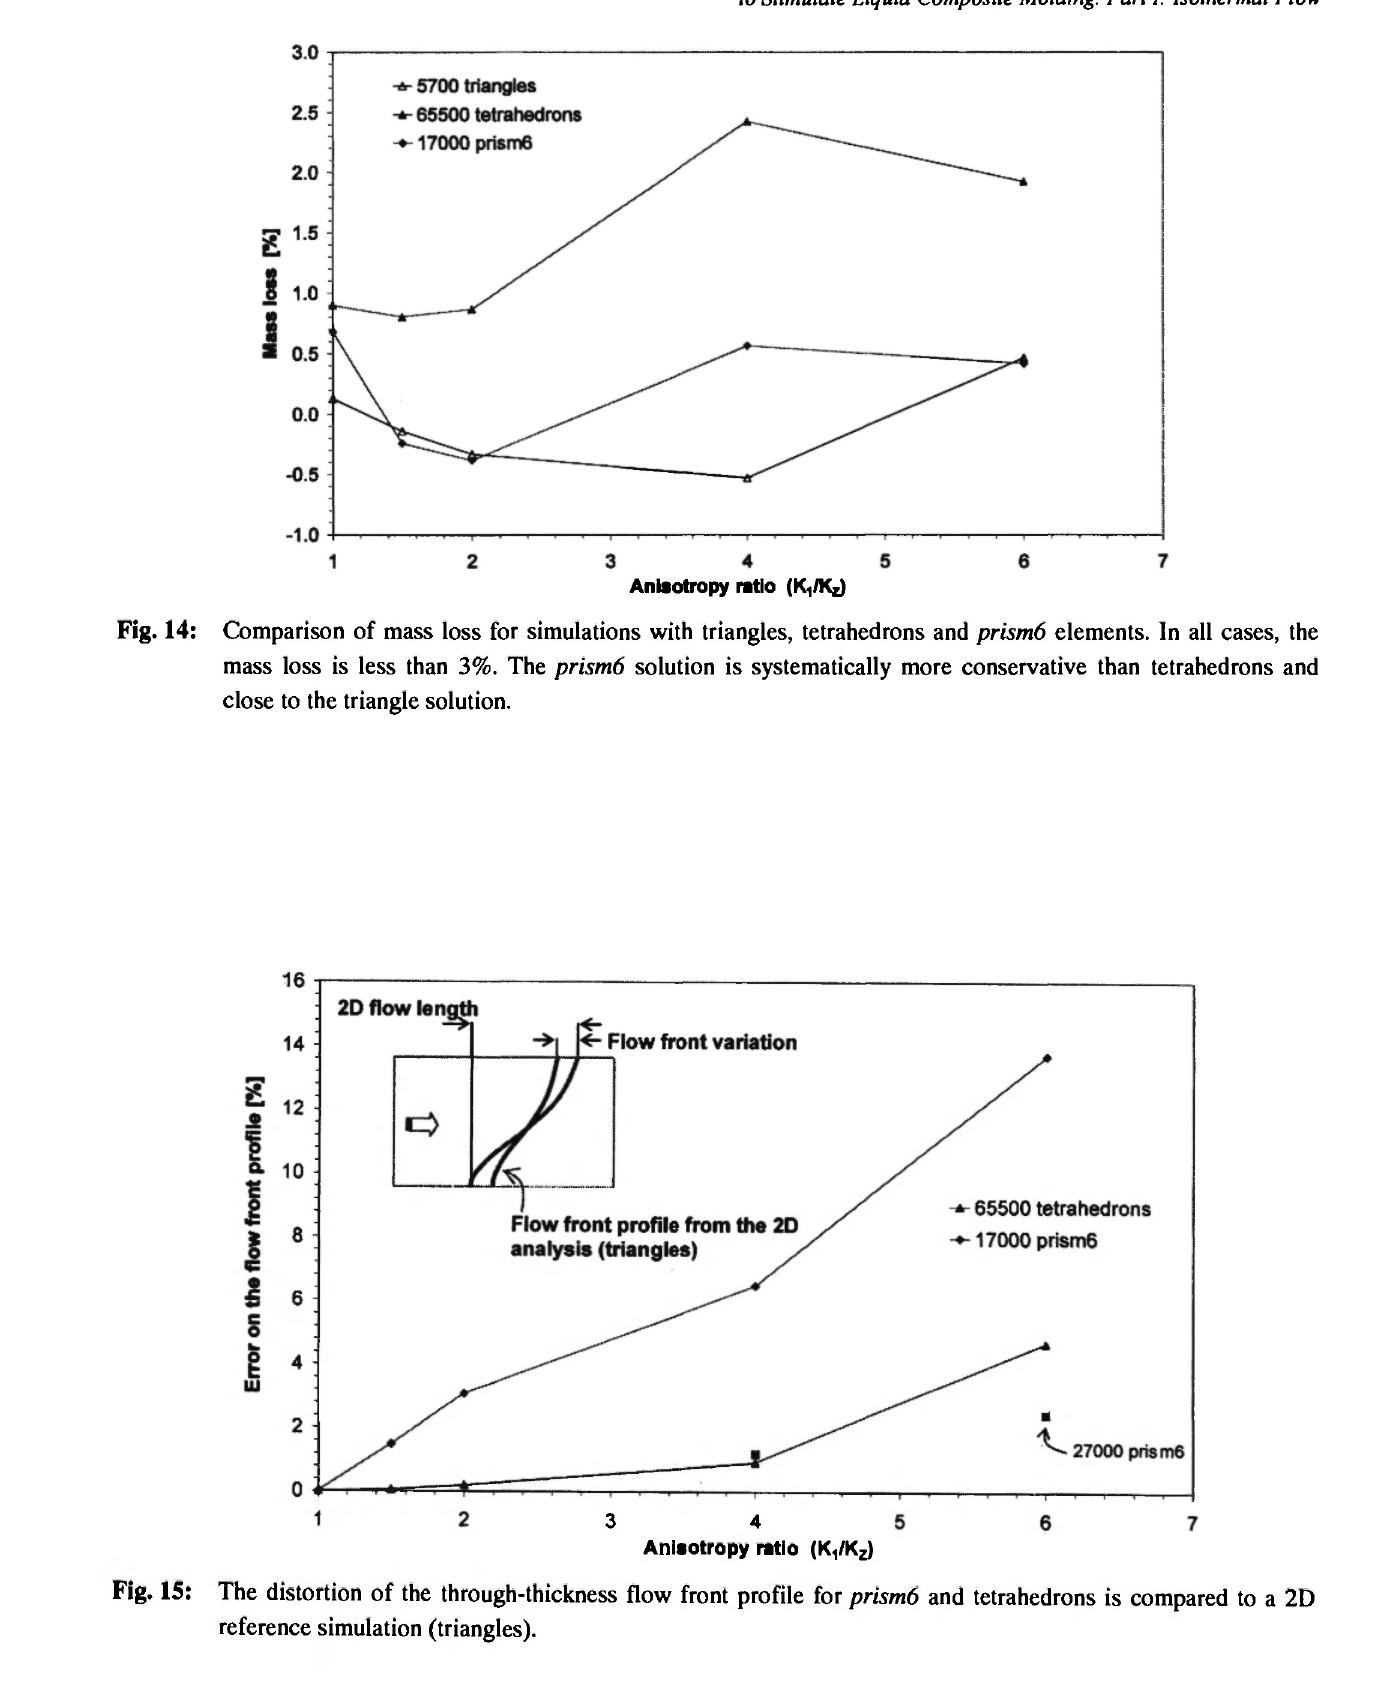
Fig. 15: The distortion of the through-thickness flow front profile for prism6 and tetrahedrons is compared to a 2D reference simulation